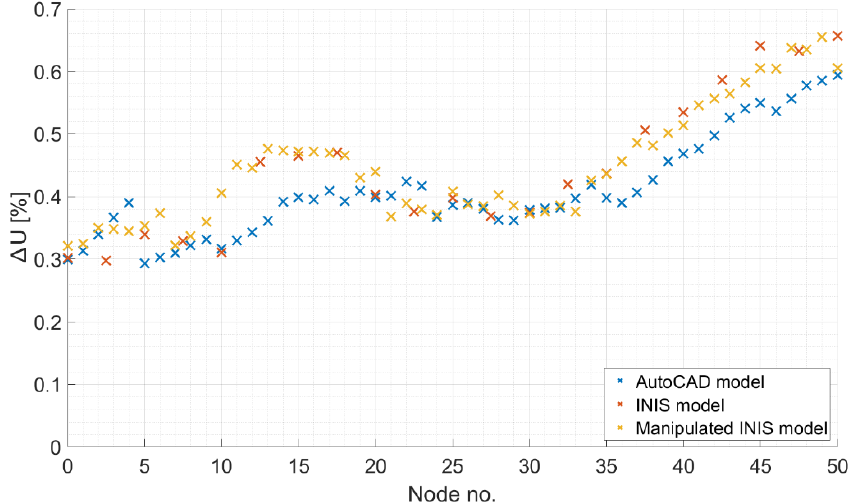
Figure 5. Average relative error of voltages for Area 18,680 with Method 2.